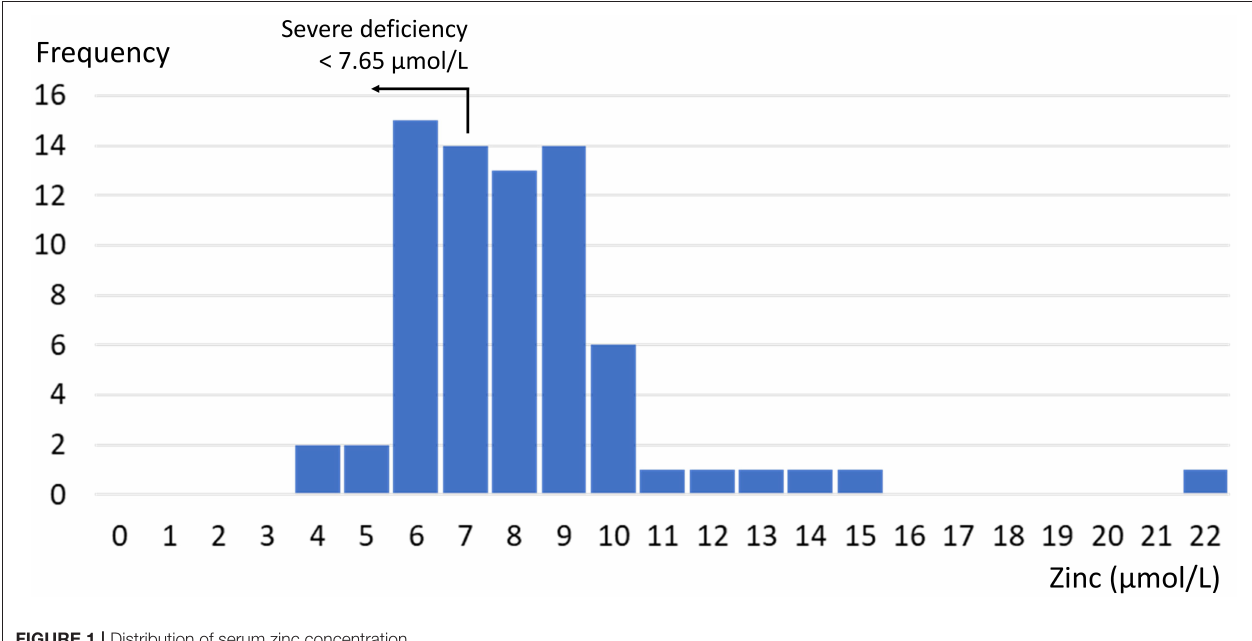
FIGURE 1 | Distribution of serum zinc concentration.